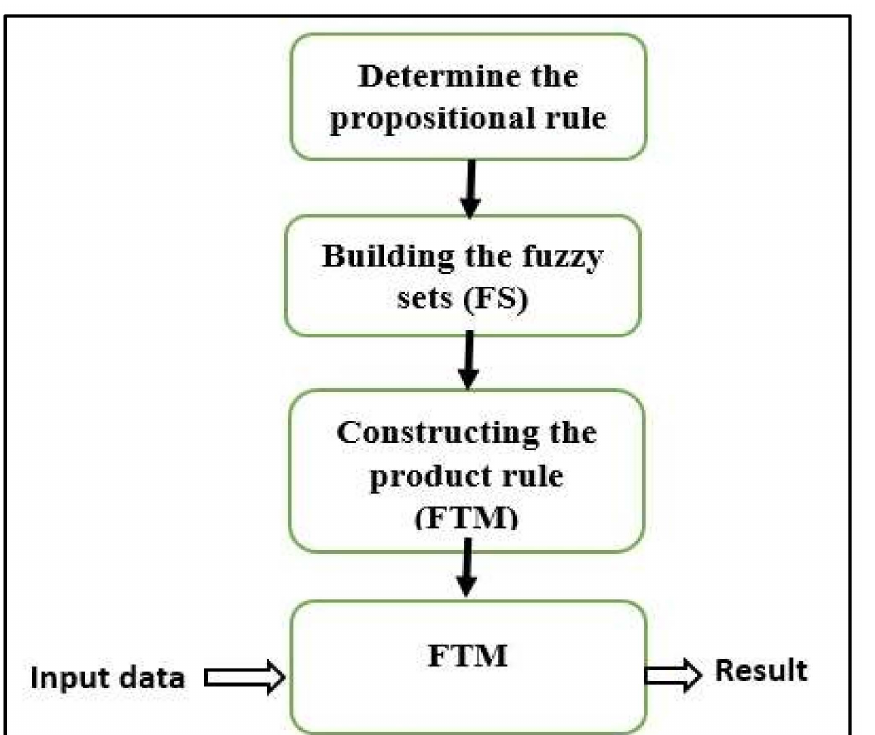
Figure 1. The FPM